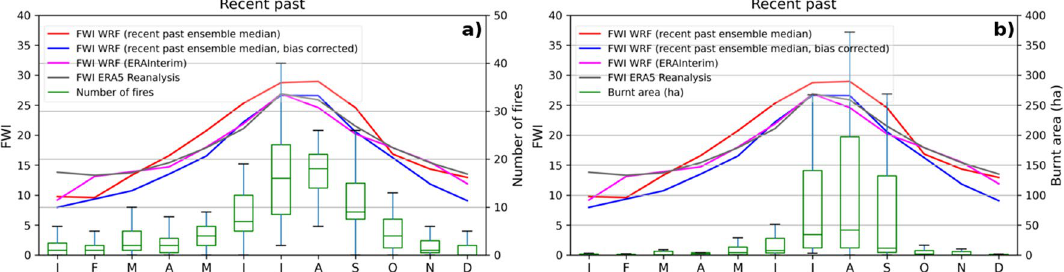
Figure 2. Monthly mean FWI of WRF median Ensemble in recent past period, 1980–2009 (red), bias corrected (blue), FWI computed from ERAInterim-WRF (magenta), and FWI ERA5 reanalysis (gray) (left scale). Annual cycle of the number of fires ( a ) and monthly burnt area ( b ) on the five western islands in recent past period (green box-plots, right scale). Boxes: monthly values of the lower quartile (Q1), median, and upper quartile (Q3). Whiskers extend from minimum to maximum monthly